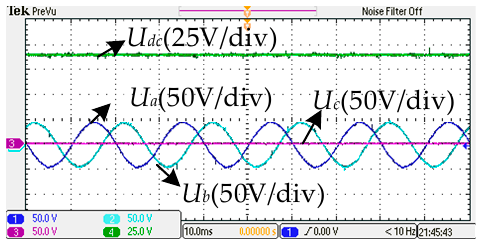
Figure 22. Three-phase grid voltage and DC voltage with no DC voltage ripples. Figure 22. Three ‐ phase grid voltage and DC voltage with no DC voltage ripples. Figure 22. Three ‐ phase grid voltage and DC voltage with no DC voltage ripples. Figure 22. Three ‐ phase grid voltage and DC voltage with no DC voltage ripples.